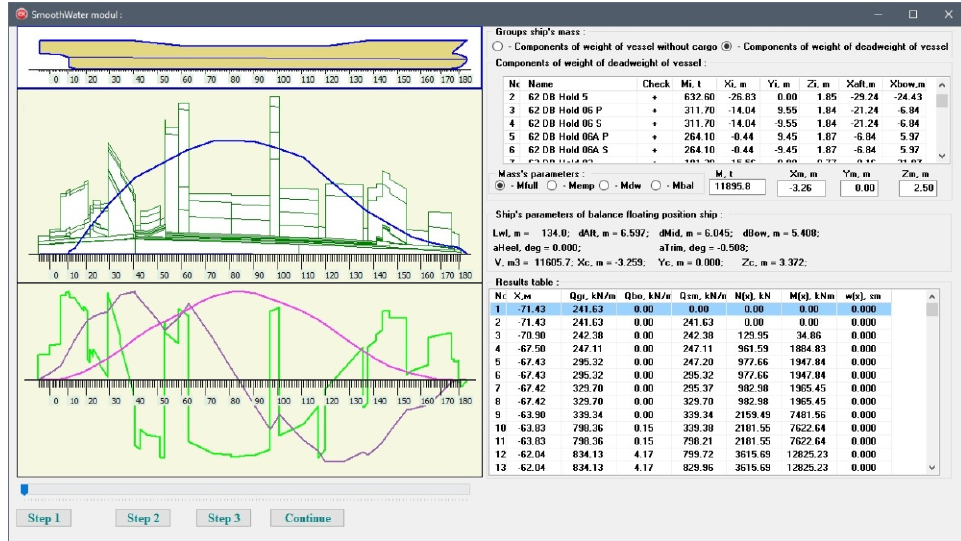
Figure 5. Calculations of still water loads based on the actual distribution of the light ship and variable ship loads.